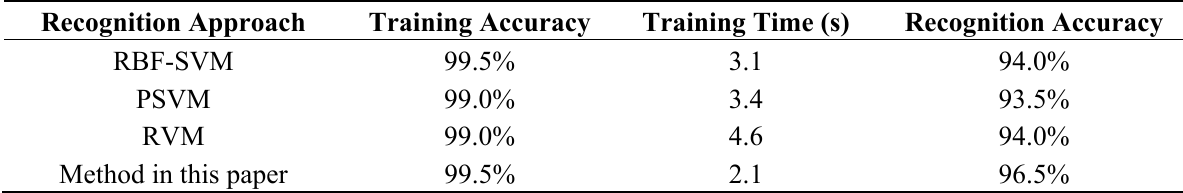
Table 5. Training accuracy, training accuracy and recognition accuracy of radar emitter recognition approaches are compared.